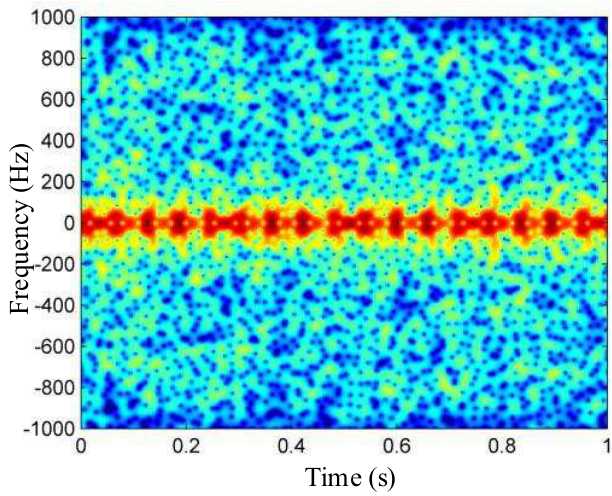
Figure 2. Micro-Doppler signature of rotors.